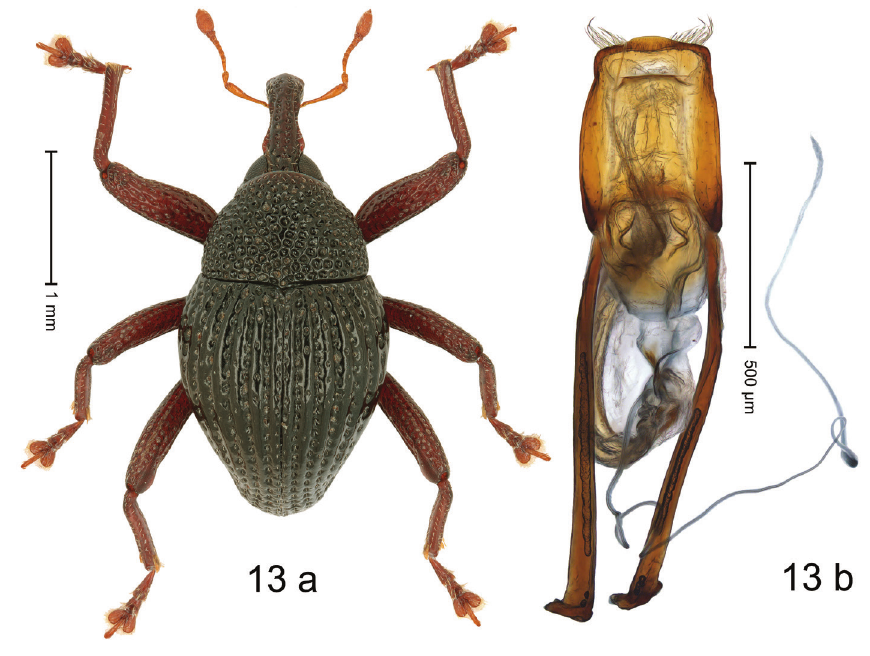
Figure 13. Trigonopterus moduai sp. nov., holotype a habitus b